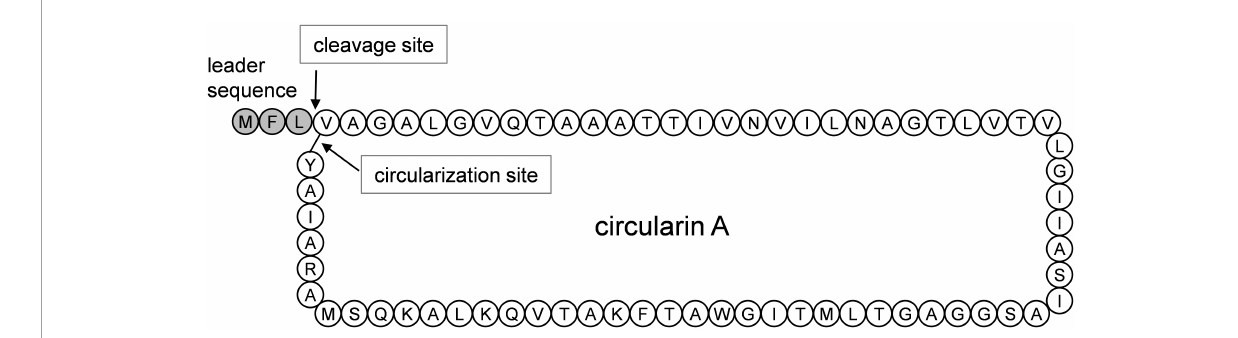
FIGURE1 Circularin A precursor peptide with the putative maturation process. The peptide bond between Leu and Val is cleaved, and a new peptide bond is formed between Trp and Val as indicated by the arrows.